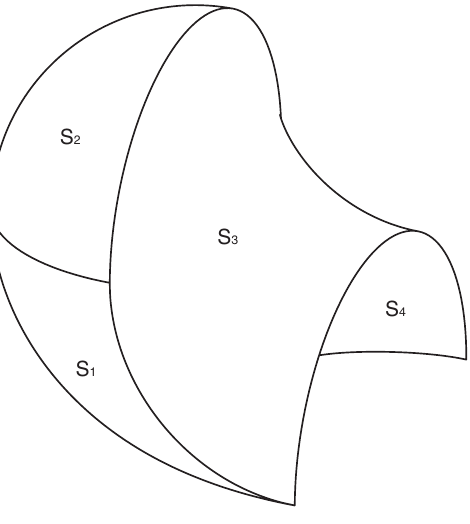
Fig. 13. Workspace surfaces for each